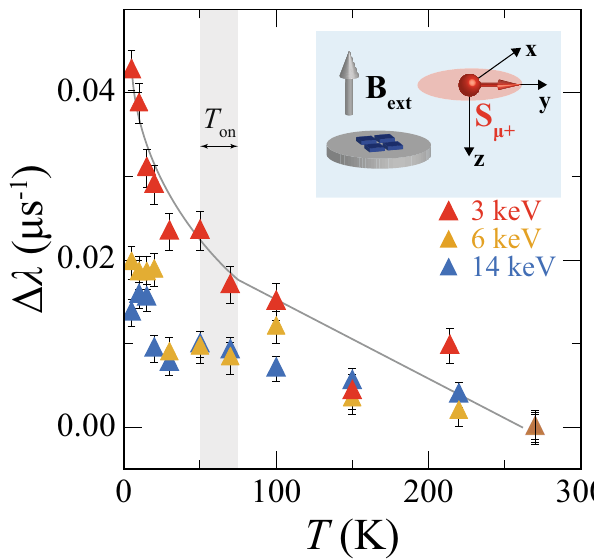
Fig. 2 Temperature dependence of magnetism in SRO 214 at different implantation depths. Shift in the muon depolarization rate, Δ λ , from the λ value measured at T = 270 K as a function of temperature T measured in a TF setup (inset) with applied fi eld amplitude B ext = 100 G at different implantation energy E values: E = 3 keV (red symbols with error bars), E = 6 keV (orange symbols with error bars) and E = 16 keV (blue symbols with error bars). The solid grey line serves as a guide to the eye and marks the T range (grey shaded region) where Δ λ changes slope for E = 3 keV, which we identify as the onset temperature T on of the magnetism in SRO 214 . The inset shows the relative orientation of the applied fi eld B ext with respect to the muon spin polarization S μ + in our orthonormal reference- axes system for the TF con fi